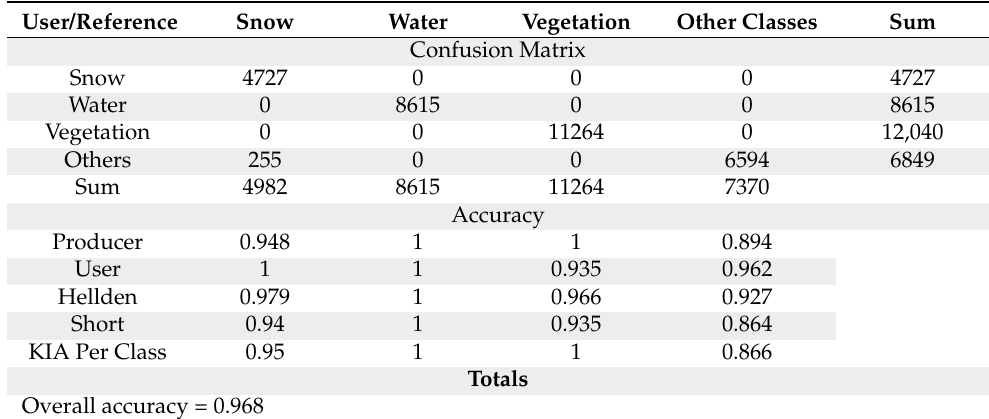
Table 3. The accuracy assessment process results for snow, water, vegetation, and other classes. The upper part shows the confusion matrix; the lower part shows the accuracy